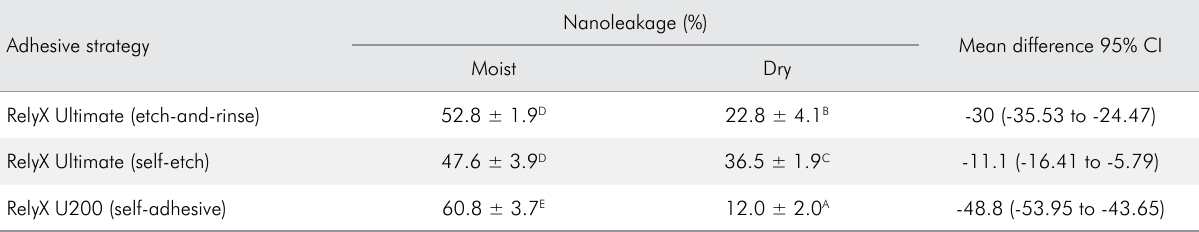
Table 2. Means, standard deviations, and mean differences for nanoleakage. Adhesive strategy